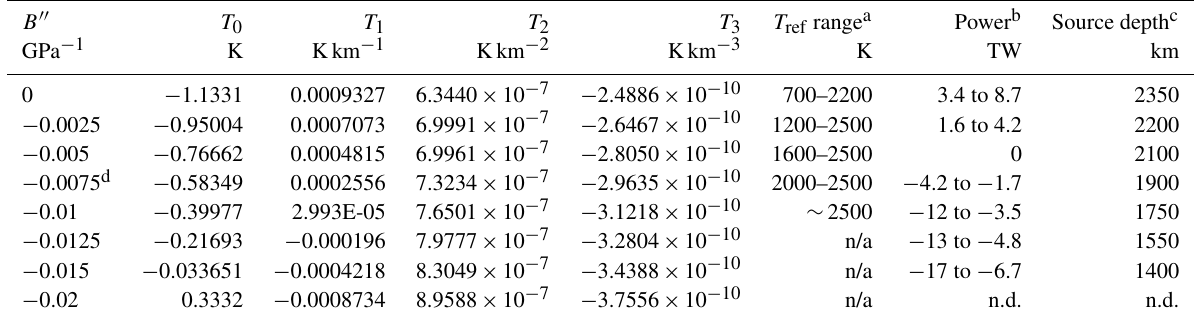
Table 1. Polynomial curve fits to the thermal gradient in kelvin per kilometer (Kkm − 1 ), with parameters for the geotherm and power curves. B (cid:48)(cid:48)